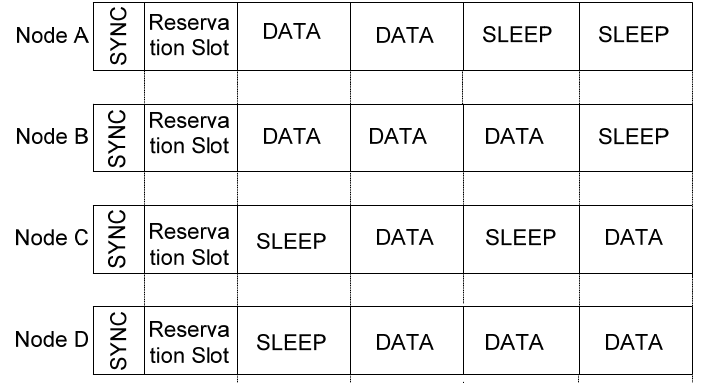
Figure 5. Timing diagram of sensor nodes working in